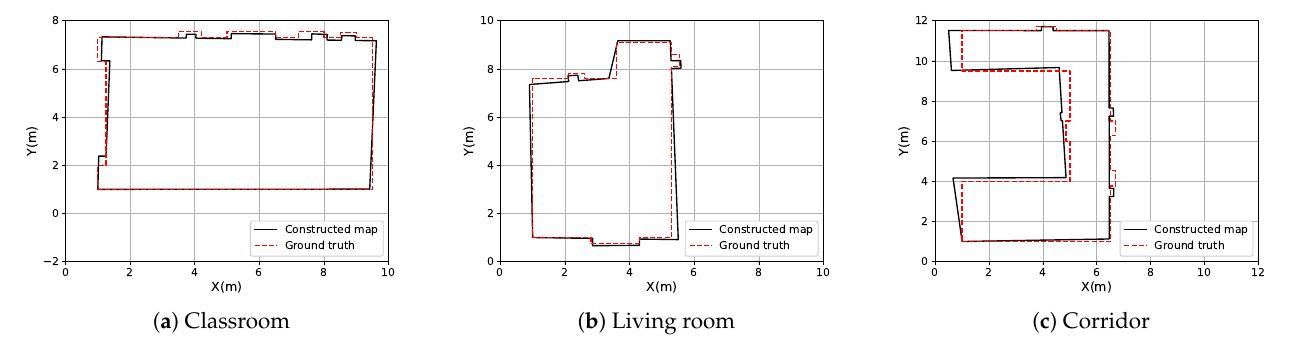
Figure 14. Comparison between reconstructed indoor floor plans and the ground truth. The red dotted line represents the real indoor plan, and the black solid line represents the indoor floor plan we built.